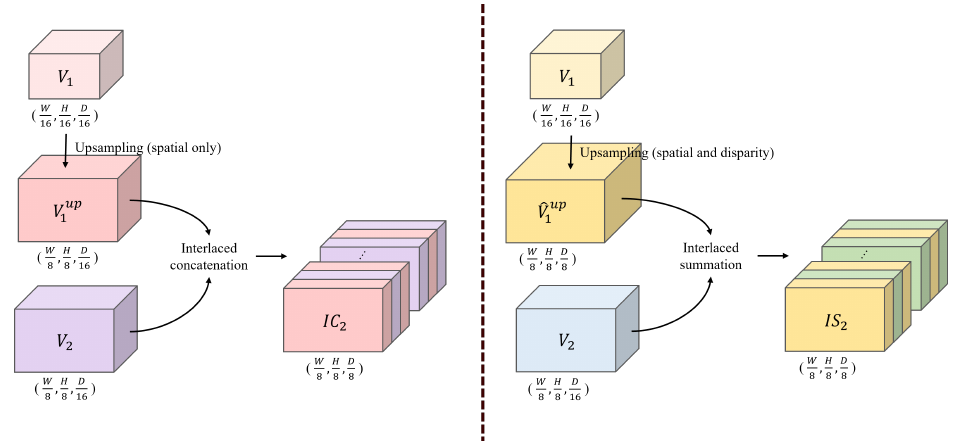
Figure 11. Details of interlaced concatenation and interlaced